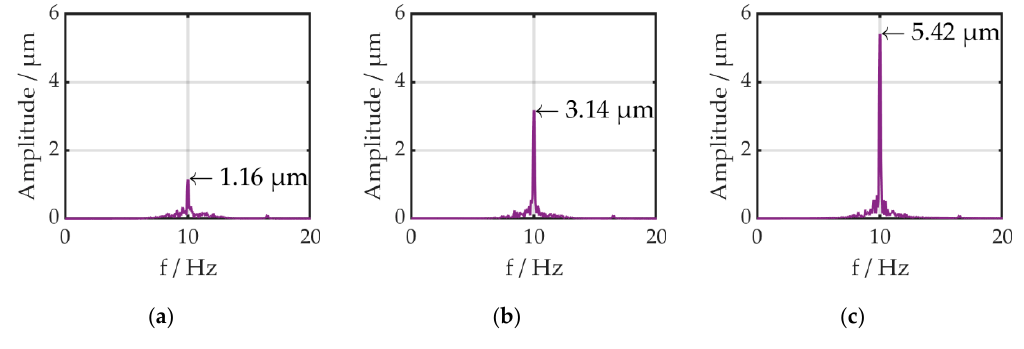
Figure 10. Amplitude with increasing current: ( a ) 0.6 A, ( b ) 1.0 A, ( c ) 1.4 A.